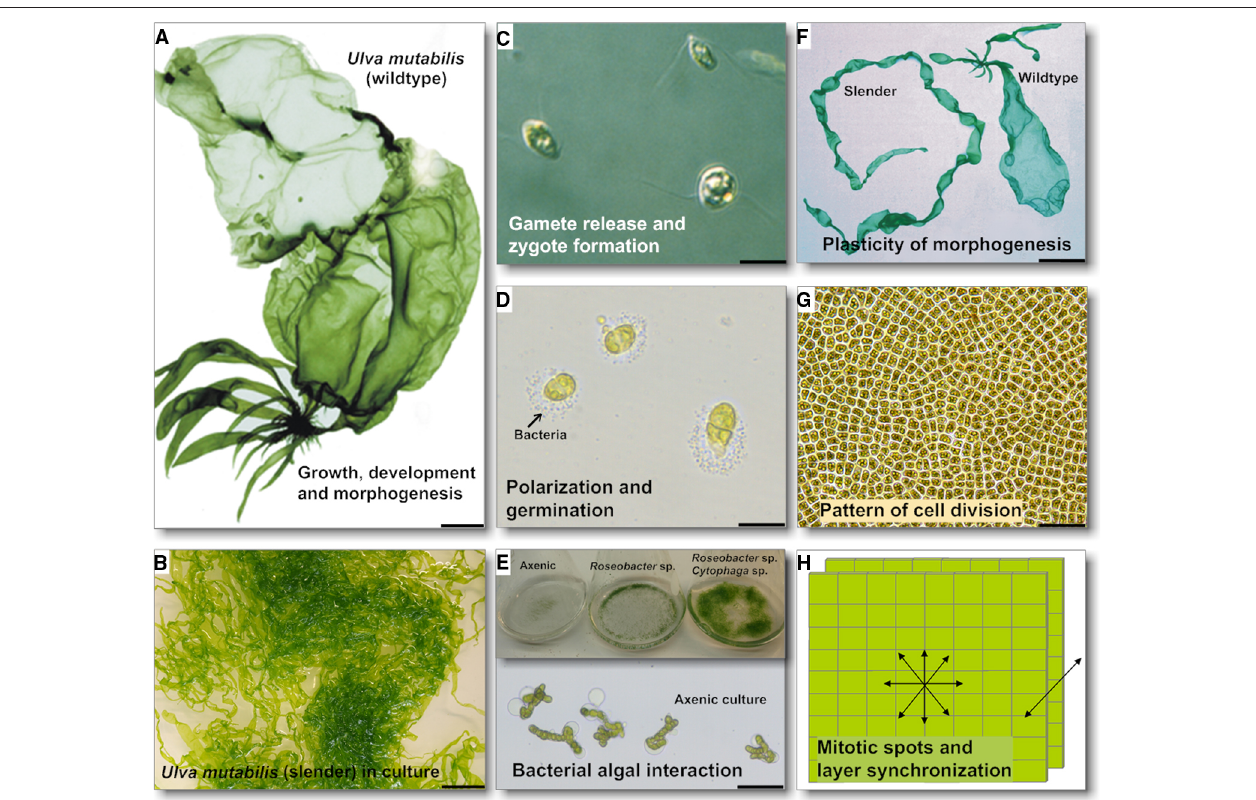
FIGURE 2 | Characteristics of Ulva , and scientific contributions to research into Ulva growth, development and morphogenesis. Key events in Ulva ontogenesis are highlighted: (A,B) The wildtype U. mutabilis and a typical culture of its developmental mutant slender are shown (scale bar = 1 cm). Regulation of gametogenesis/zoosporogenesis, gamete/zoospore release and zygote formation are important checkpoints in the isomorphic, haplodiplontic Ulva life cycle. The wildtype (A) released gametes ( C, scale bar = 5 µ m) upon synchronous sporulation in the apical part of the thallus ( = discharged colorless gametangia). (D) Unmated gametes propagate as a haploid strain and ger- minate with a clear polarization for primary rhizoid formation upon settlement, where bacteria that accumulate can be observed (biofilm formation). (E) Under axenic conditions Ulva develops into a callus with no cell differentiation